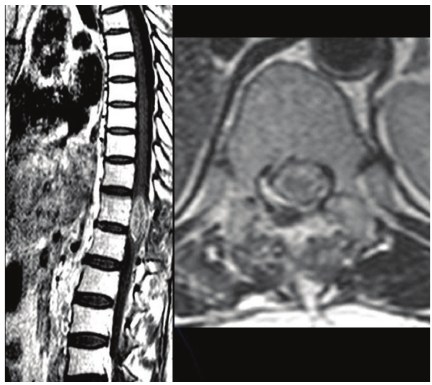
Figure 2: Postoperative spinal MRI showed not only evacuated inner part of the lesion but also remnant tumor adherent to neural tissue.